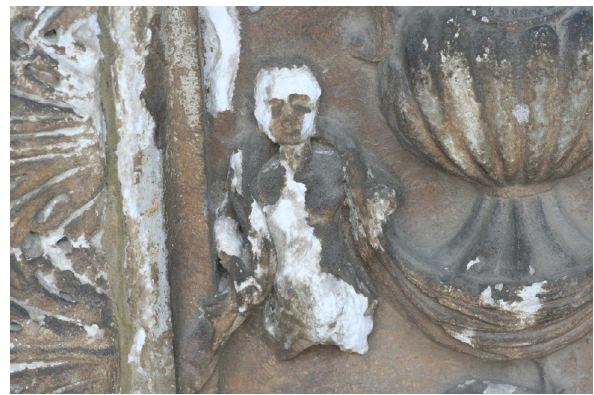
Figure 5. A detail of the bas-relief in right pilaster before the